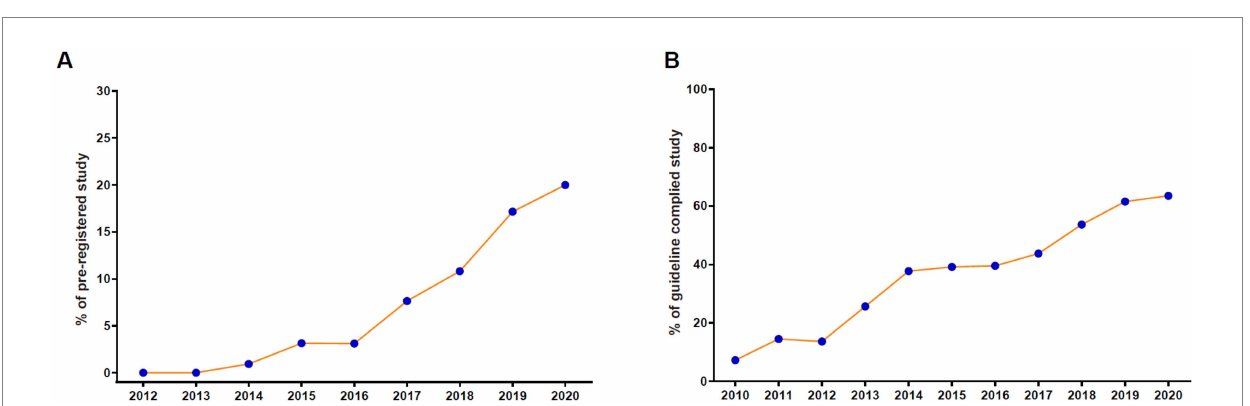
FIGURE 5 The percentage of pre-registered studies (A) and guideline complied studies (B) indexed by web of science core collection over